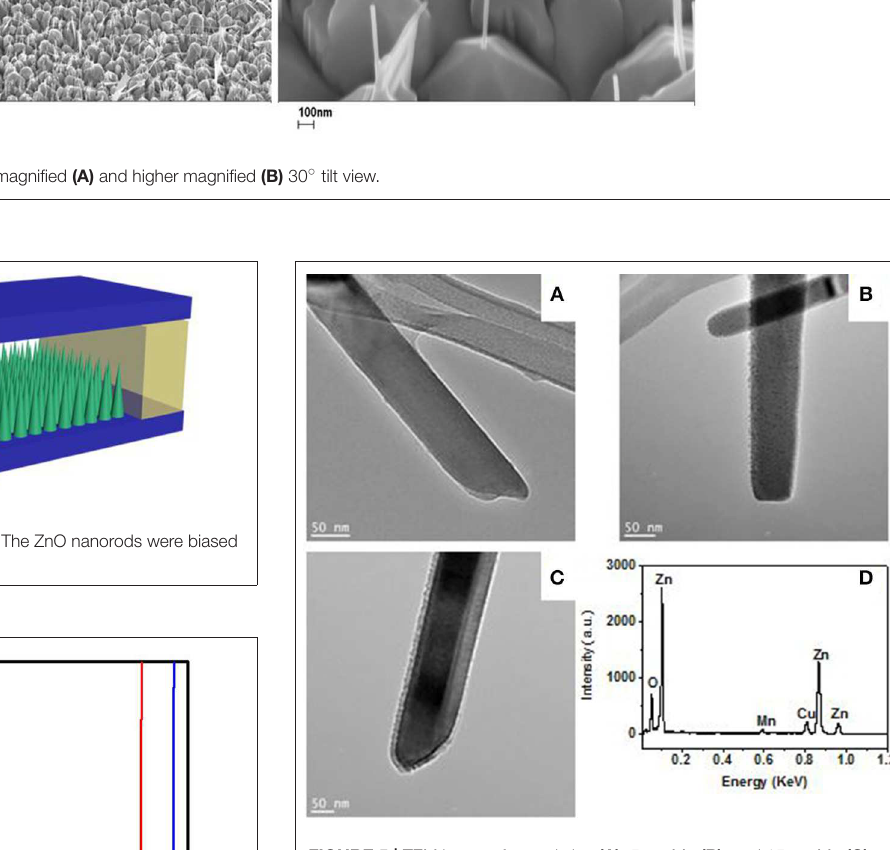
FIGURE 5 | TEM images for a pristine (A) , 5nm Mn (B) , and 15nm Mn (C) decorated ZnO nanorod. The EDX (D) is corresponding to 15nm Mn decorated ZnO